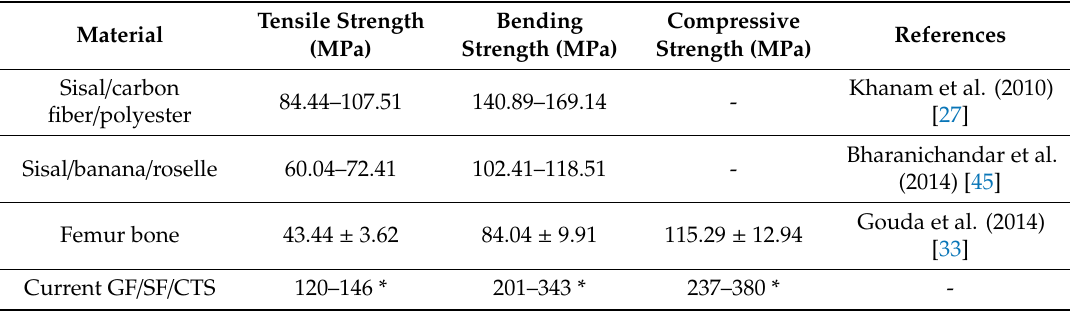
Table 6. Mechanical properties of reported work on hybrid composites for orthopedic